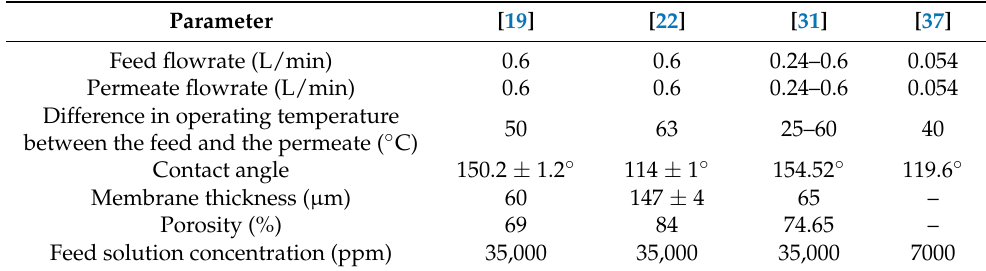
Table 1. Different polystyrene (PS) membrane systems for water desalination via direct contact membrane distillation